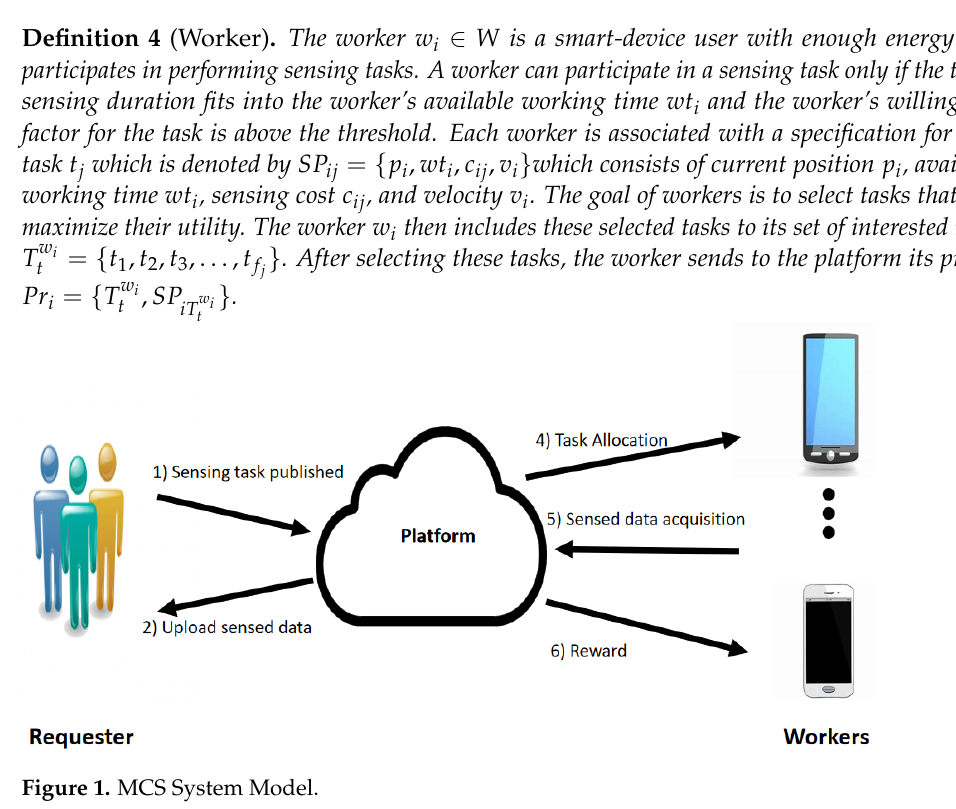
Figure 1. MCS System